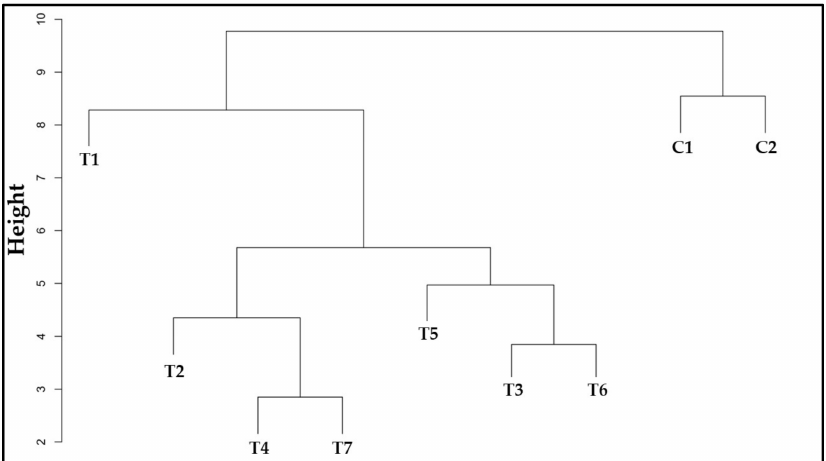
Figure 13. Dendrogram displaying the distances between the different inoculation treatments of strawberries. Ward’s method for minimum variances and the Euclidean distance were chosen. Comparison between treatments and controls. C1: control without inoculation + fertilization 100% of N and P; C2: control without inoculation + fertilization 30% of N and P; T1 : Azospirillum brasilense (Ab-v5); T2: Bacillus megaterium (0004); T3: Brevibacillus fluminis (MET12M2); T4: Ab-v5 + 0004; T5: Ab-v5 + MET12M2; T6: 0004 + MET12M2; T7: Ab-v5 + 0004 +